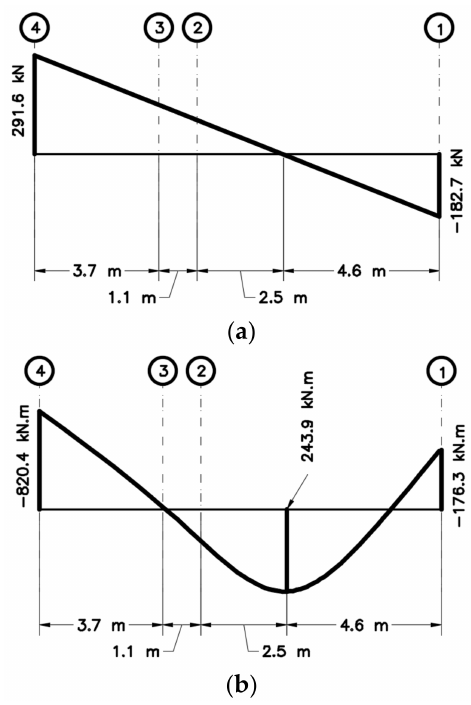
Figure 13. Efforts in beam V3 to the infinite time, after iterative process: ( a ) shear force (kN); ( b ) bending moment (kN